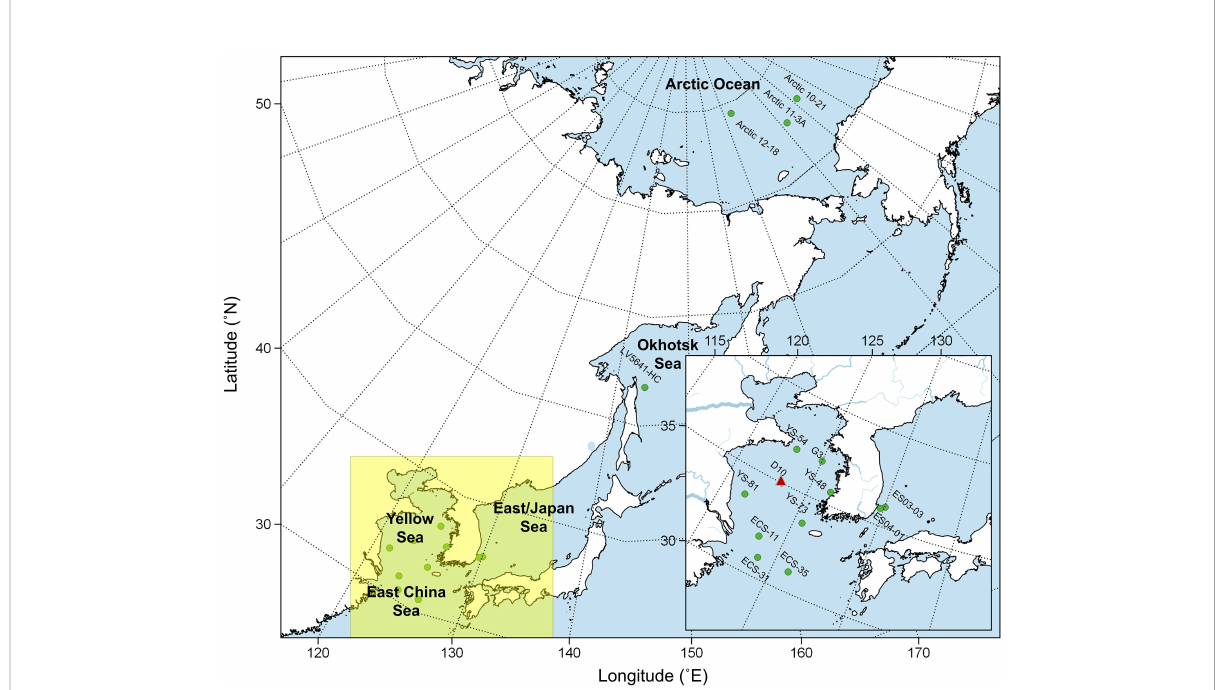
FIGURE 1 Sampling sites of this study. The triangle symbol indicates a core sample collected in the Yellow